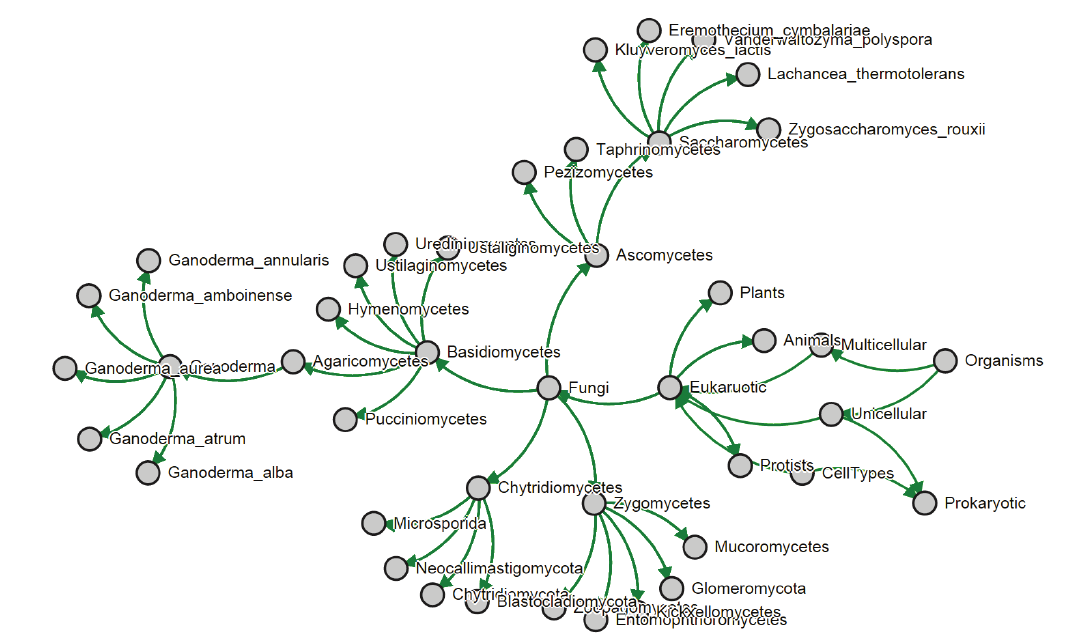
Figure 12: GITIRBio functional relationship using the D3 Viz component.